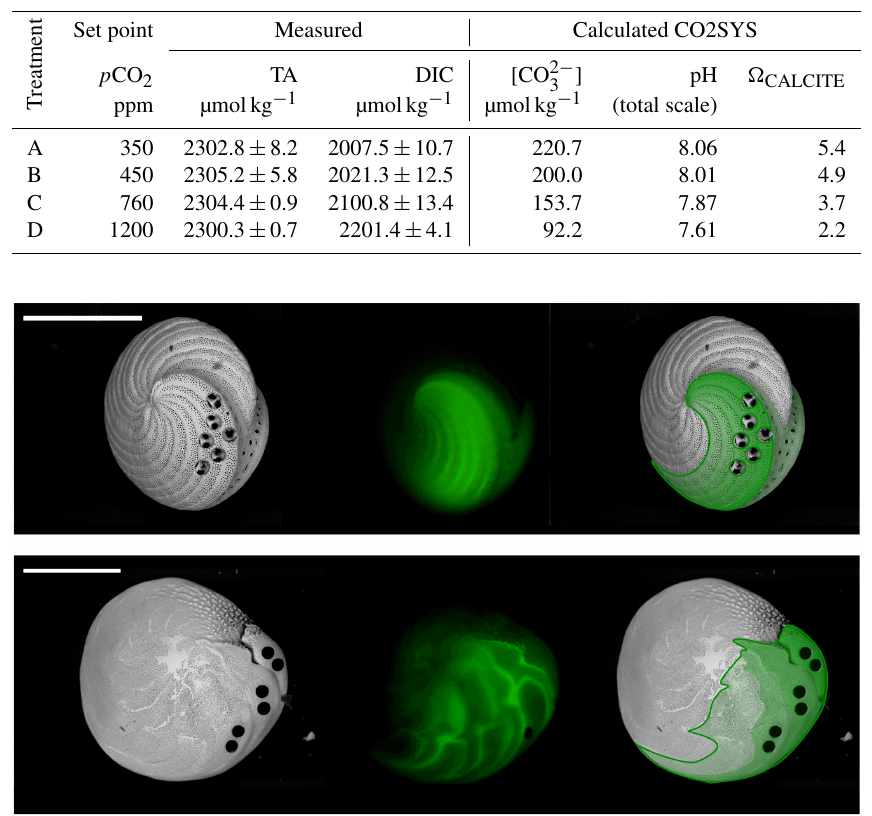
Figure 2. SEM (left) and fluorescence microscope (middle) photographs of A. angulatus (top series) and A. gibbosa (bottom series) to assess newly formed chambers for laser ablation (right). Scale bar =